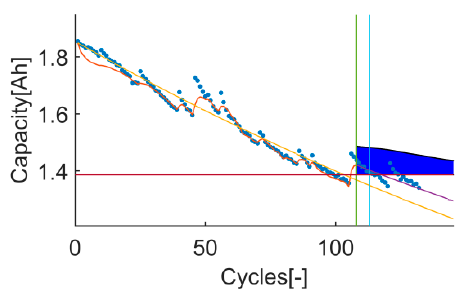
Figure 28. Time-instant figure of test 4 on t 102 .